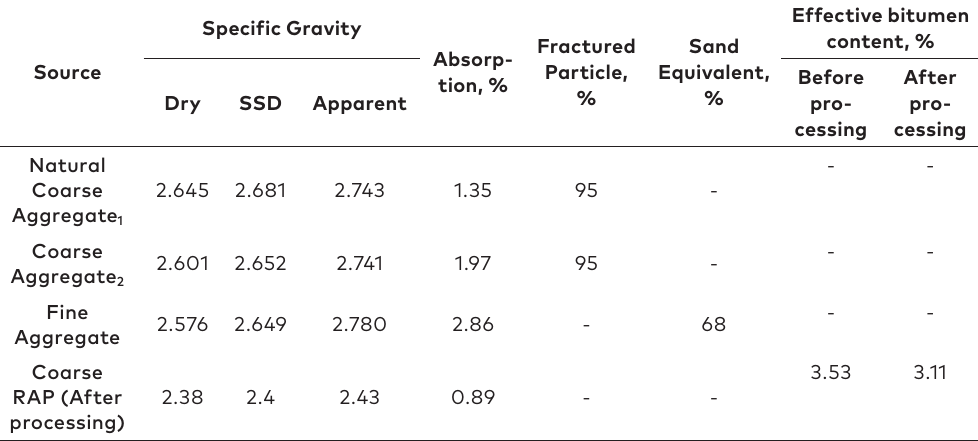
Table 2. Properties of the aggregates and RAP used in this research